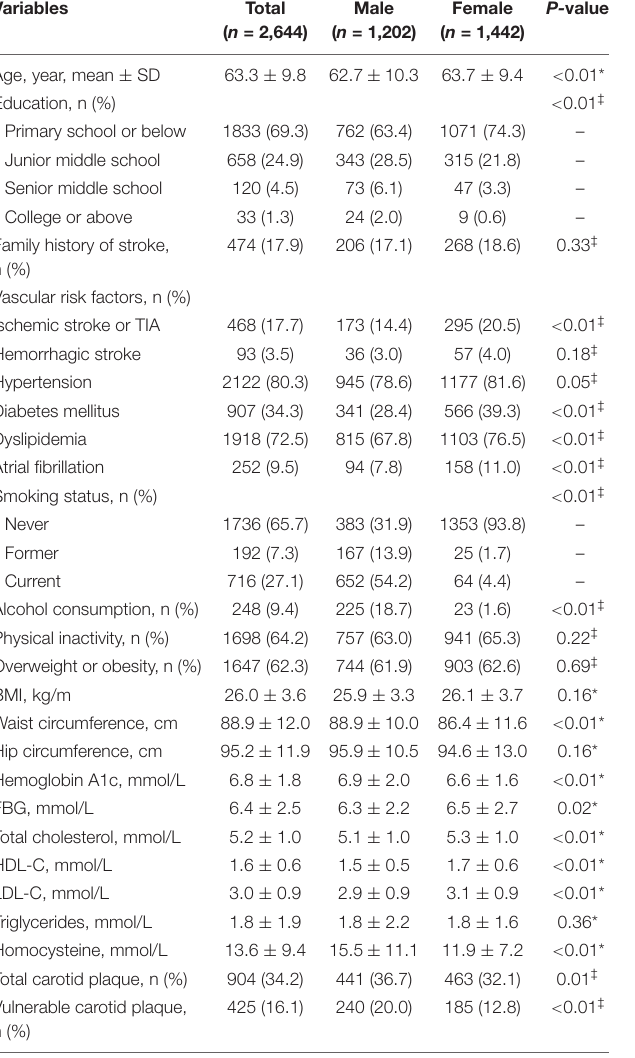
TABLE 1 | Gender differences in the characteristics of individuals at high risk of stroke and the prevalence of carotid plaque. Variables